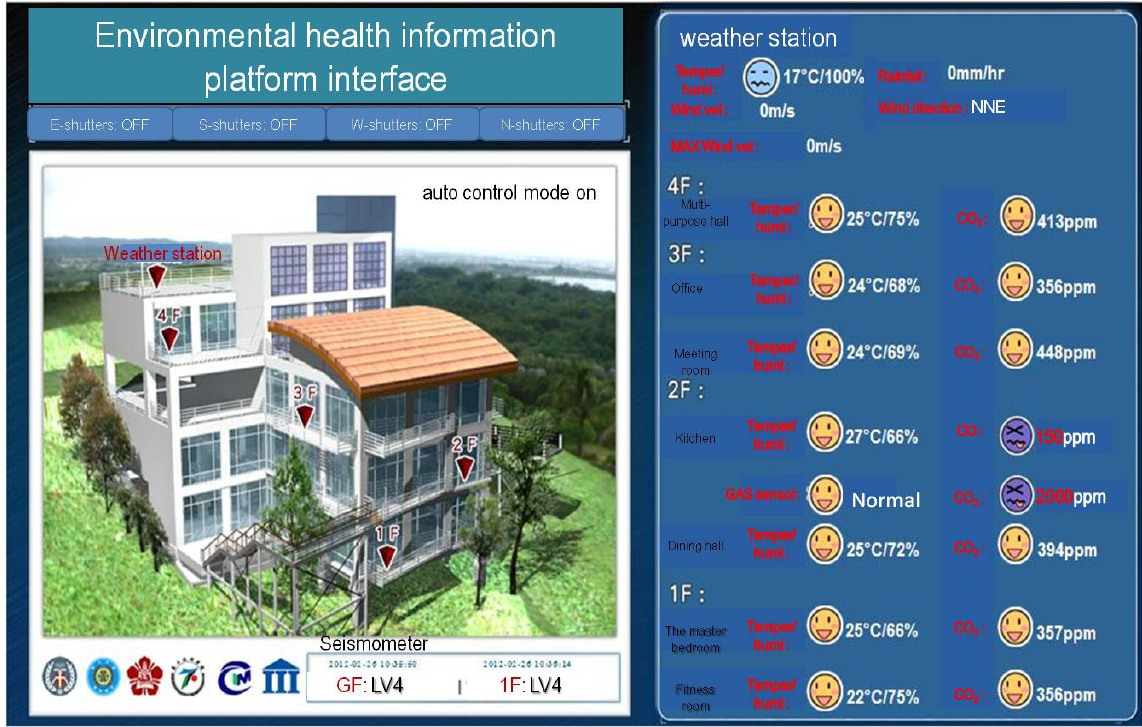
Figure 10. Environmental health information platform interface